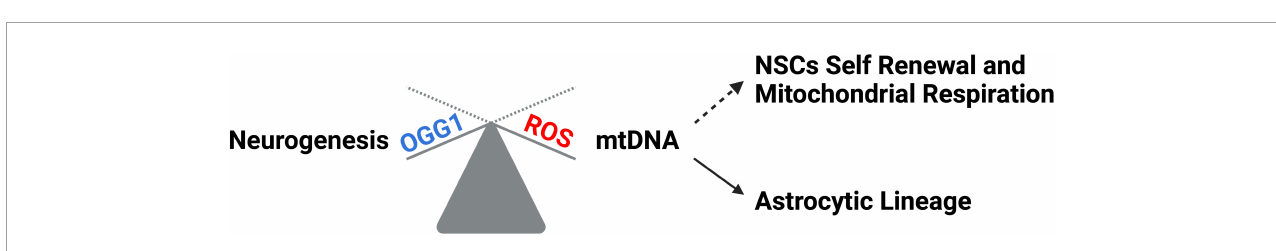
FIGURE3 mtDNA impact on neural differentiation. ROS increase leads to mtDNA damage which correlates with NSCs self-renewal reduction, decreased mitochondrial respiration, and a shift toward the astrocytic lineage. OGG1 repair system protects NSCs from ROS-dependent mtDNA damage, thus favoring neuronal